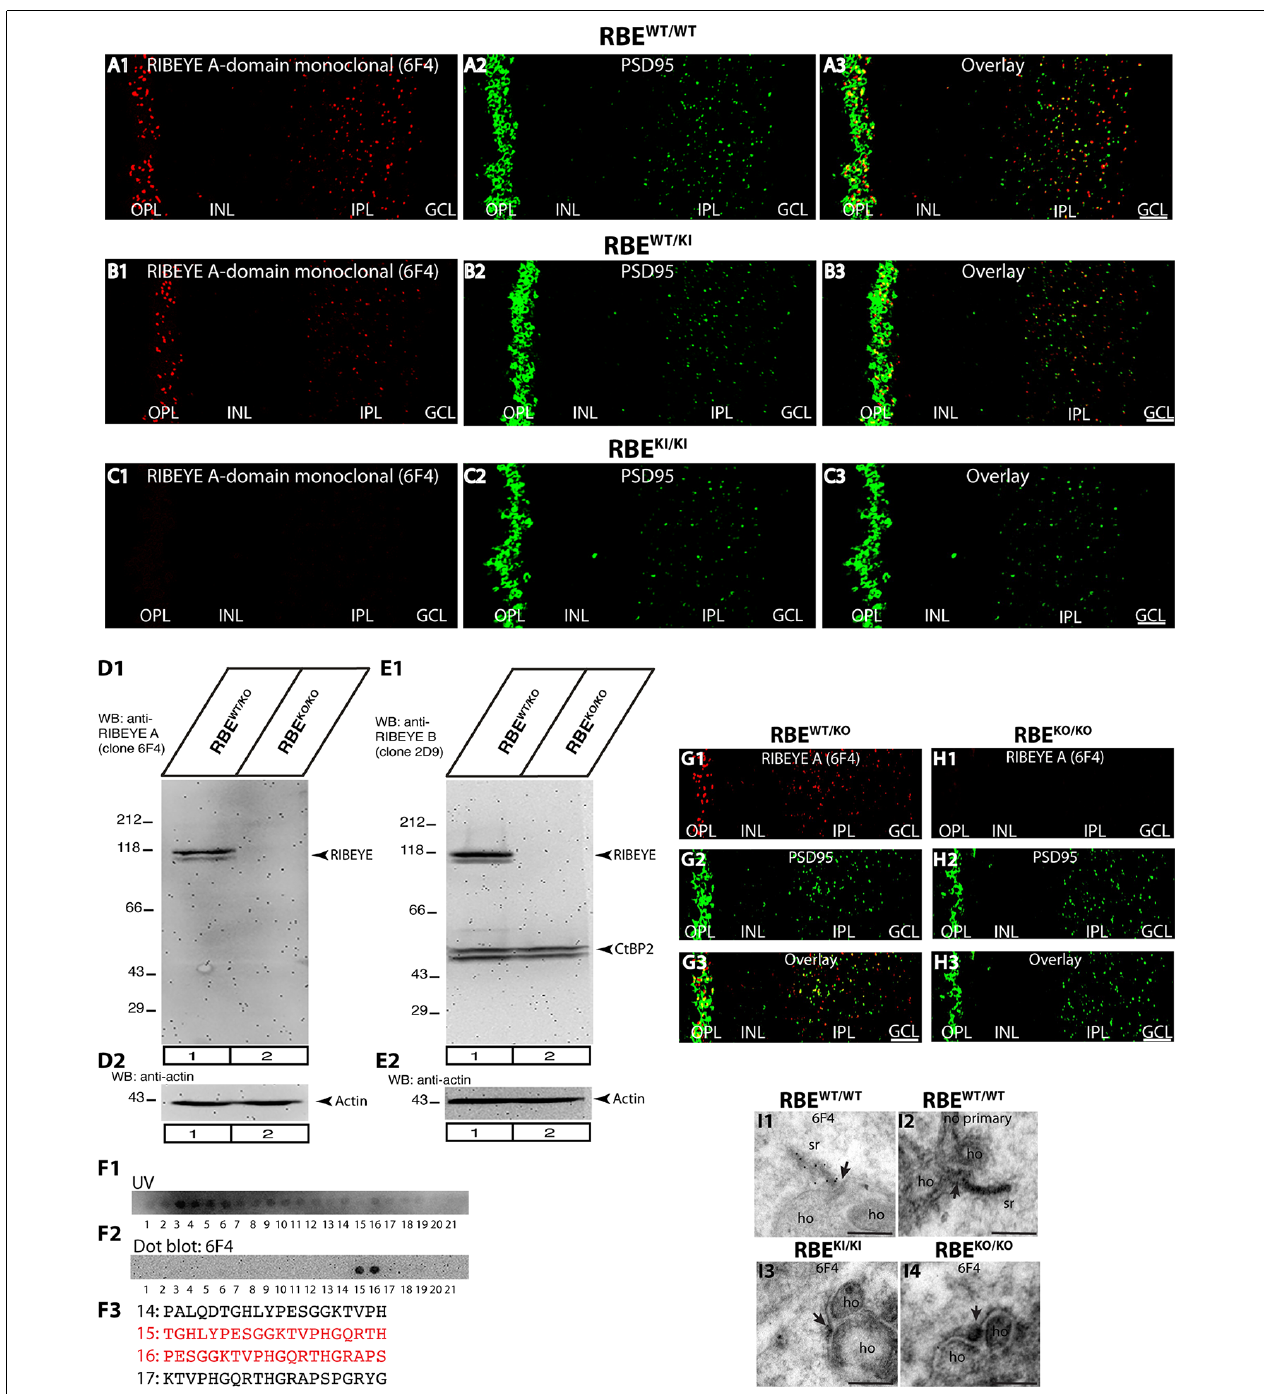
FIGURE 5 | Confirmation of absence of RIBEYE A-domain immunosignals in the retina of RBE KI/KI mice with a novel mouse monoclonal antibody against RIBEYE A-domain (6F4). (A1–A3,B1–B3,C1–C3) 0.5 µ m-thin retina sections from the indicated littermate mice (RBE WT/WT , RBE WT/KI , and RBE KI/KI ) with mouse anti-RIBEYE A-domain (clone 6F4) and rabbit anti-PSD95. (C1) RIBEYE A-domain immunosignals were completely absent in the OPL and IPL of RBE KI/KI mice. The specificity of the novel anti-RIBEYE A-domain antibody 6F4 was verified by different experiments. (D1,D2) Retinal lysate from RBE WT/KO and RBE KO/KO mice were probed by WB analyses with anti-RIBEYE A-domain antibody 6F4 (D1) and anti-actin (D2) . Anti-actin signals were used as a loading control. (E1,E2) For comparison, retinal lysate from RBE WT/KO and RBE KO/KO mice were also probed by WB analyses with anti-RIBEYE B-domain antibody 2D9 (E1) and anti-actin (E2) , as previously described (Dembla et al., 2018). The anti-actin signals were used as loading controls. (F1,F2) Overlapping peptide spots, that cover the RIBEYE A-domain fusion protein